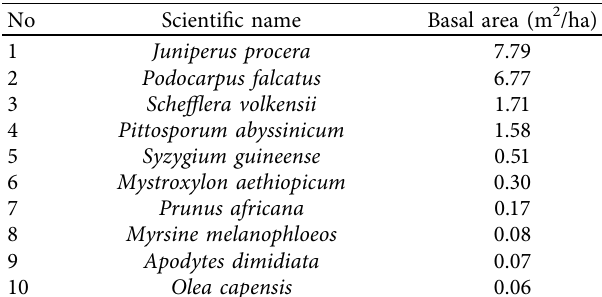
Figure 4: Distribution of overall woody species density among DBH classes. Table 2: Basal area of the top 10 dominant species in the Gennemar